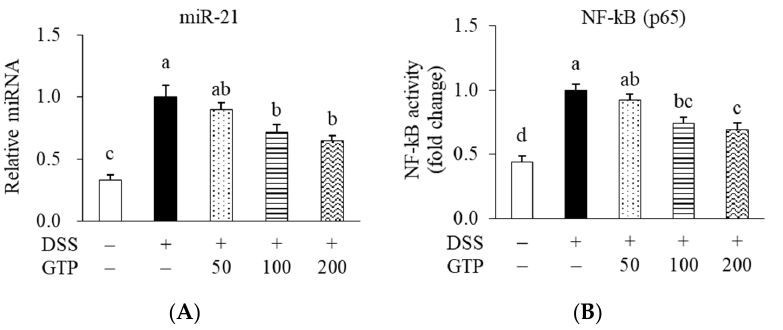
Figure 5. Effect of GTP on miR ‐ 21 expression ( A ) and NF ‐κ B activity ( B ) in colon tissue. Values are